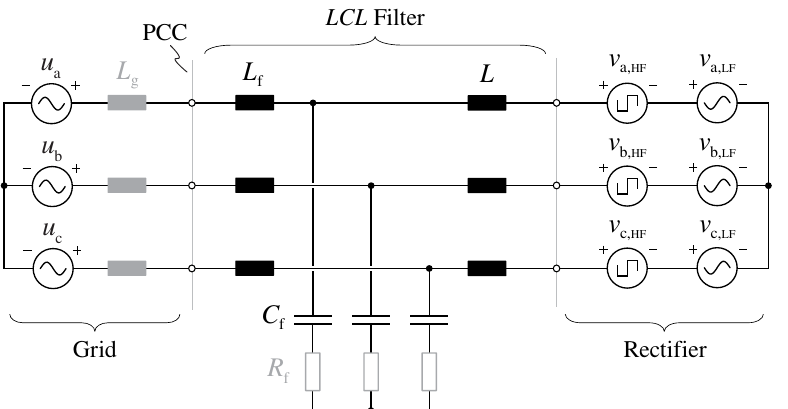
Figure 2. Equivalent circuit of the considered three-phase system, consisting of the active rectifier, the LCL filter and the grid. L is the converter-side inductance, C f is the filter capacitance and L f is the grid-side filter inductance. Additionally, L g represents the grid internal inductance and R f is the filter damping resistance. Since these components are not always present or quantitatively meaningful to the analysis, they are shown in grey.